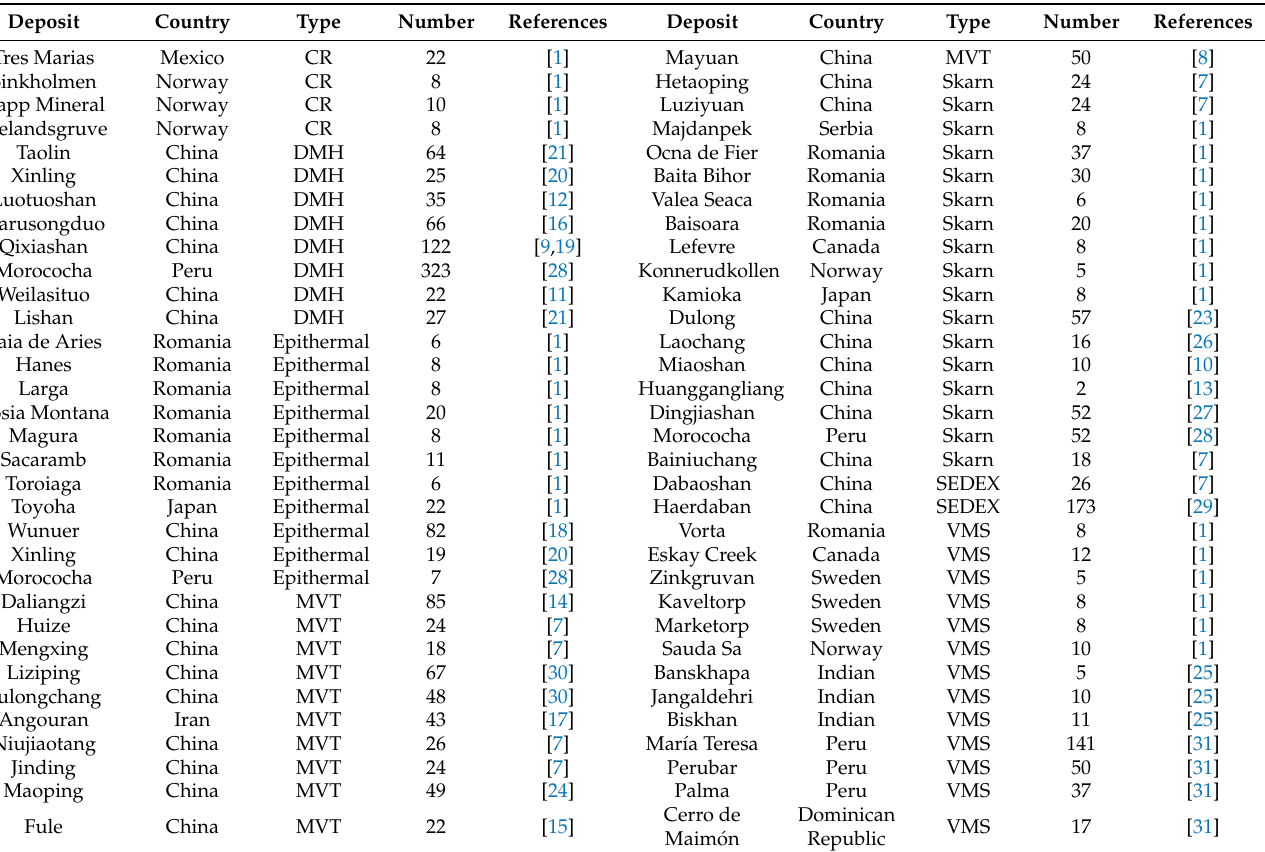
Table 1. Summary of the collected sphalerite LA–ICP–MS